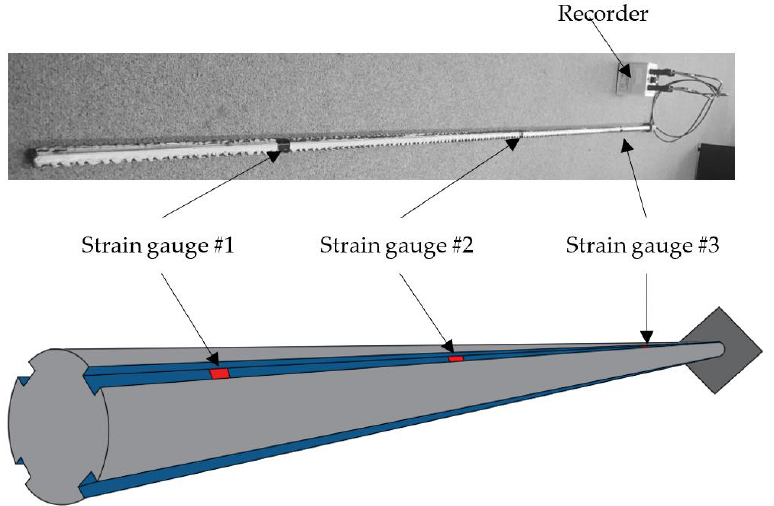
Figure 5. Exemplary scheme of instrumented rock bolt with strain gauges installed on the three measurement levels.